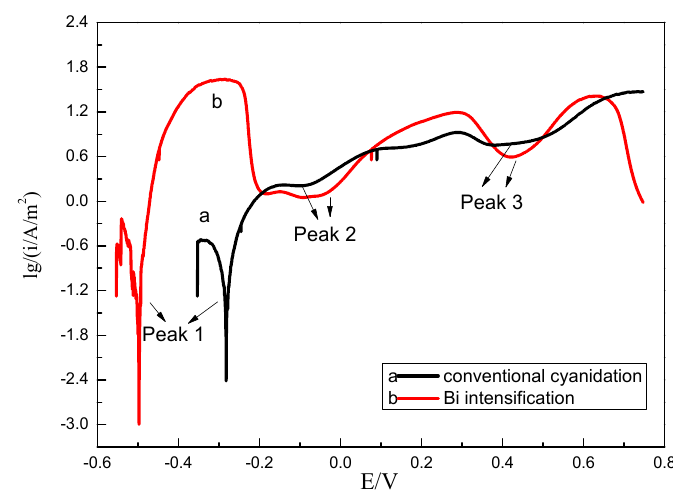
Figure 4. Tafel curves of gold electrode under conventional and Bi intensification cyanidation.